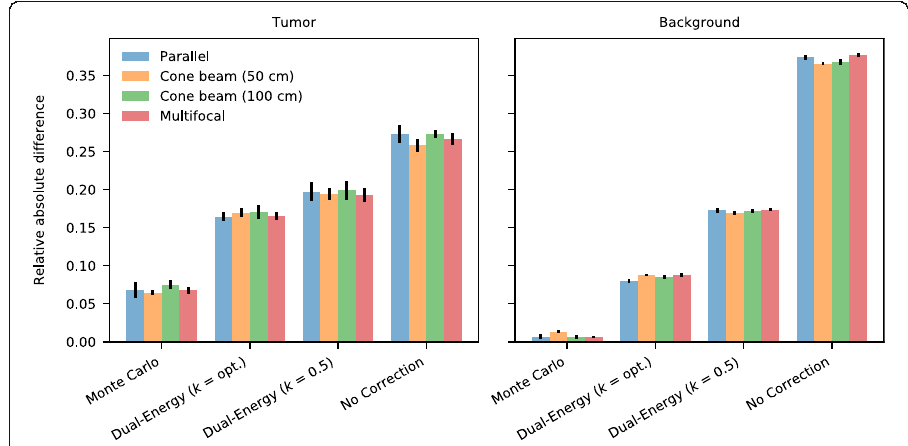
Fig. 11 The relative absolute difference, normalized to the mean activity, of the reconstructions with the phantom (ground truth), shown separately for the tumor and the background region, for the four